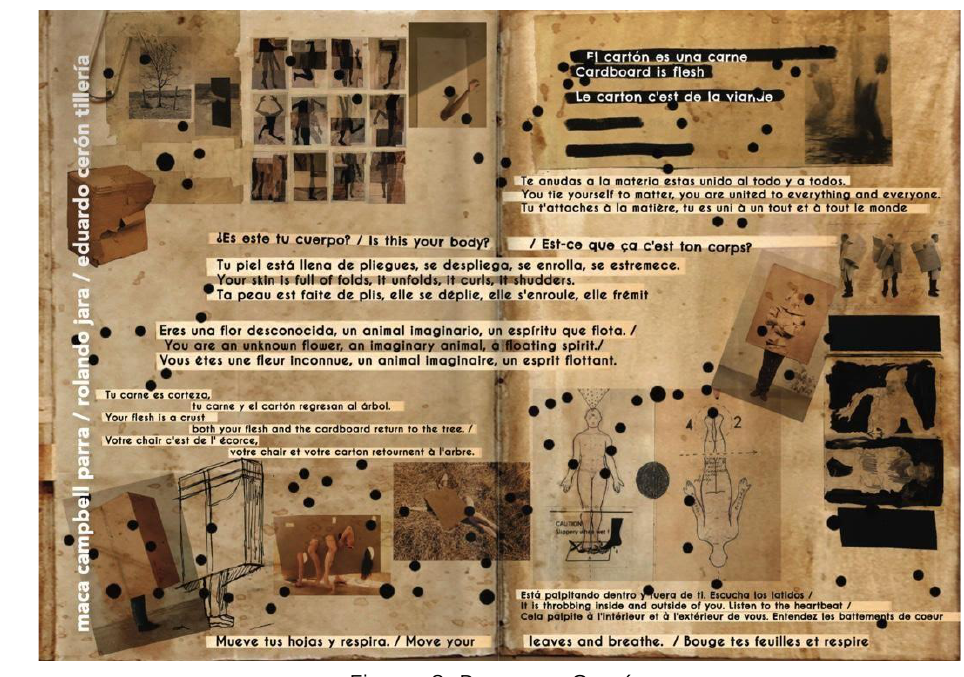
Figure 8 : Proyecto Cartón Macarena Campbell- Parra, Rolando Jara, Eduardo Cerón -Tilleria Language is an Intangible Bridge artist